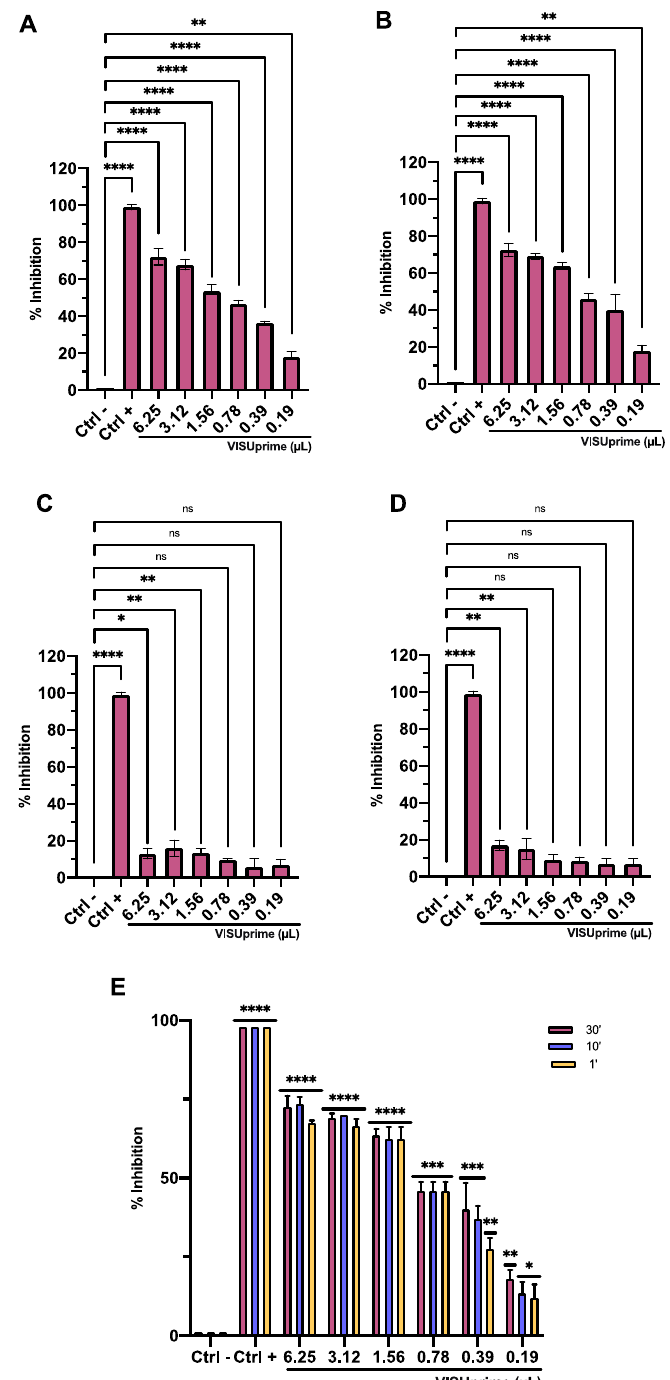
Figure 7. Antiviral activity of Visuprime against HSV-1 in four plaque reduction assays: ( A ) co-